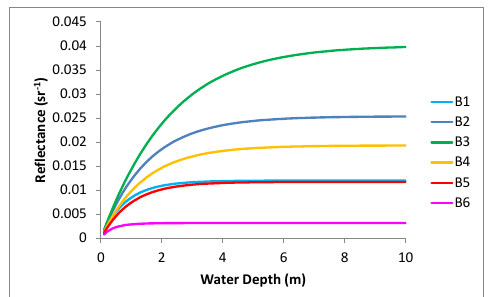
Figure 3. Variation of reflectance with water depth for the first 6 spectral bands of WorldView-2 for coastal sea water with a dark seabed.